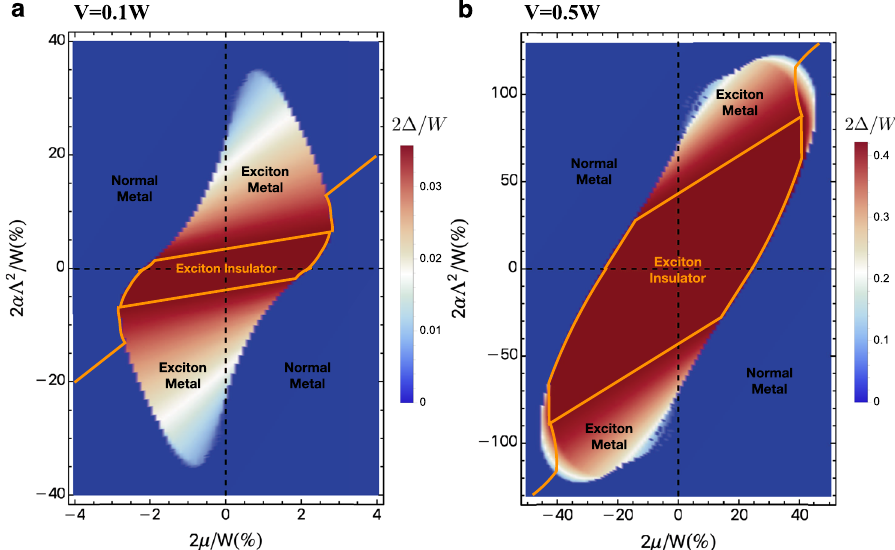
Fig. 7 Mean- fi eld phase diagram. The plot shows the zero-temperature mean- fi eld phase diagram - the intervalley exciton order parameter Δ as function of the μ and α for a V = 0.1 W and b V = 0.5 W. The yellow contour is the phase boundary of the exciton insulator as well as the contour for half- fi lling.